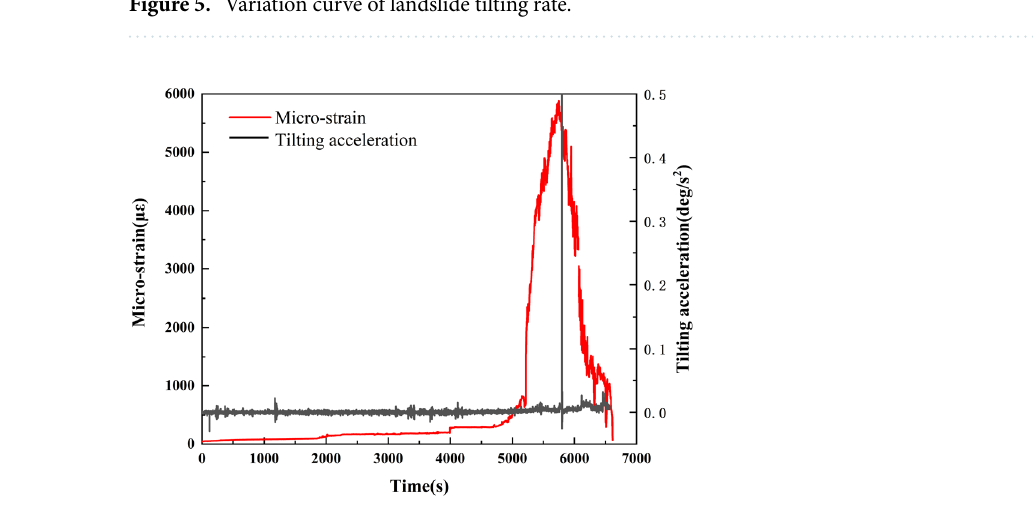
Figure 5. Variation curve of landslide tilting rate.